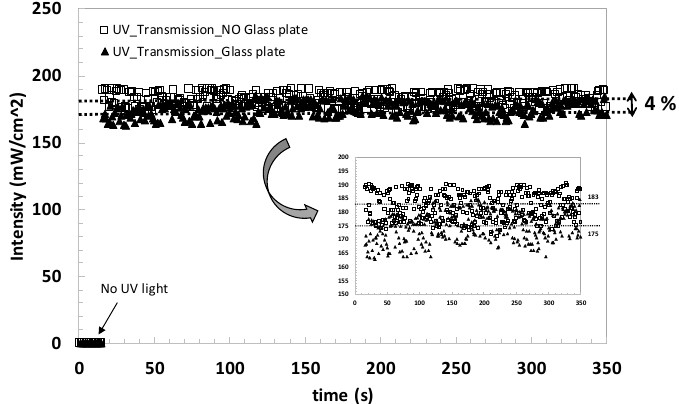
Figure 4. Recorded ultraviolet (UV) light intensity data vs. exposure time when the radiation passed